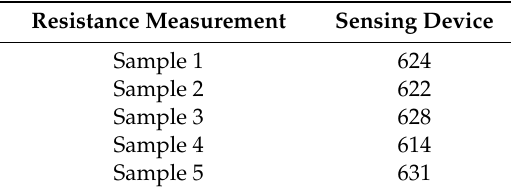
Table 7. Experiment 3 resistance measurement results in Ω .